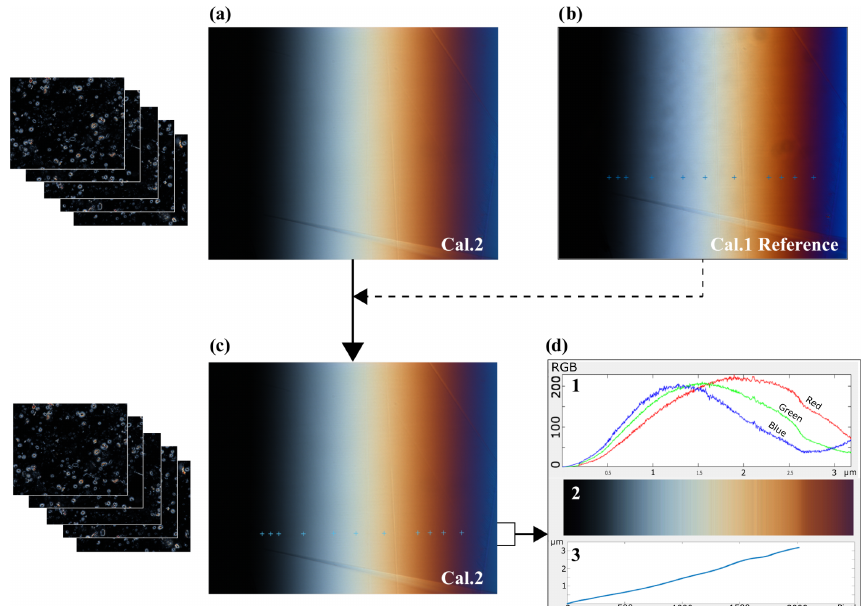
Figure 1. (a) Session image of reference calcite wedge (Cal. 2) taken with the same microscope settings as the coccolith images that are going to be taken later. (b) Reference image of the calcite wedge (Cal. 1) and the points where the thickness has been measured using a tilting compensator (Coord 1). Notice that although they are similar, neither the frame nor the light are exactly the same as the image of Cal. 2. (c) Session image of Cal. 2 with the automated calculated equivalent points of known thickness. (d) 1 Color band spectrum along the line profile. 2 RGB color rectangle showing in lines each point line color. 3 Thickness profile along the wedge line.